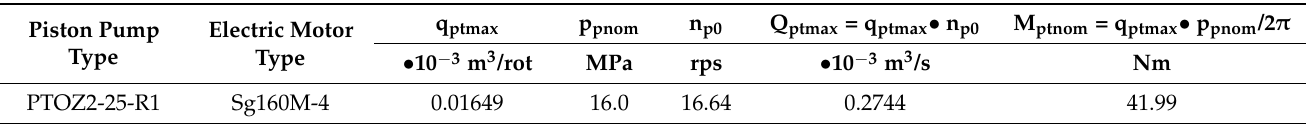
Table 1. The main technical parameters of the experimental tested piston pump PTOZ2-25-R1 produced by PZL-Hydral Wrocław